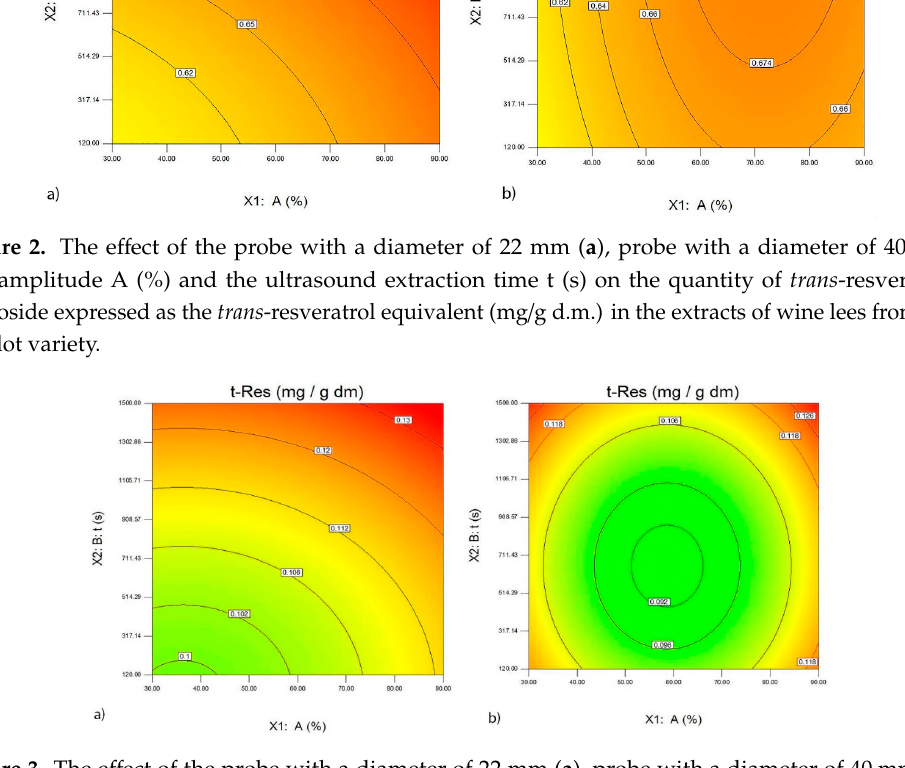
Figure 3. The effect of the probe with a diameter of 22 mm ( a ), probe with a diameter of 40 mm ( b ), amplitude A (%) and the time of ultrasound extraction t (s) on the quantity of trans -resveratrol (mg/g d.m.) in the extracts of the wine lees of the Vranac